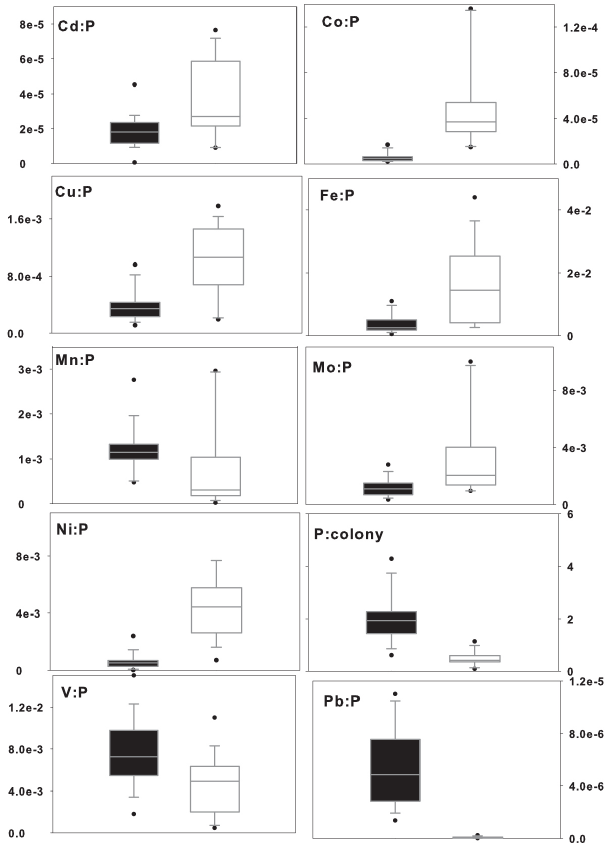
Fig. 3. Box-plots representing the scavenged (filled boxes) and in- tracellular (open boxes) metal pools measured in field populations of Trichodesmium (all of them in mol:mol, with exception of P that is reported as nmol per colony). The solid line represents the me- dian, the dimensions of the box delineates the 25th and 75th per- centile confidence intervals and the error bars show the 10th and 90th percentile confidence intervals.